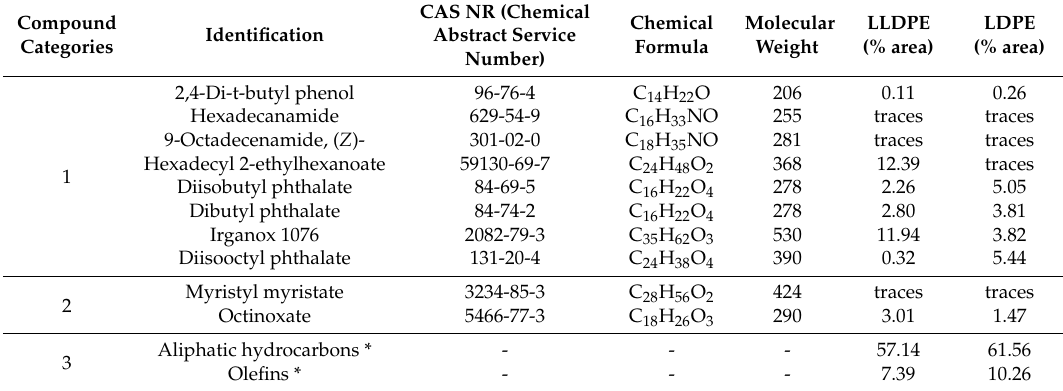
Table 6. Organic extractable profile extracted using the Head Space Solid Phase microextraction (HS-SPME) method and analyzed by gas chromatography-mass spectrometry (GC/MS) expressed as a percentage of linear low-density polyethylene (LLDPE) and low-density polyethylene (LDPE) from empty untreated final packaging divided into three different categories: (1) compounds associated with the initial ingredients, (2) impurities related to processing, and (3) degradation products of